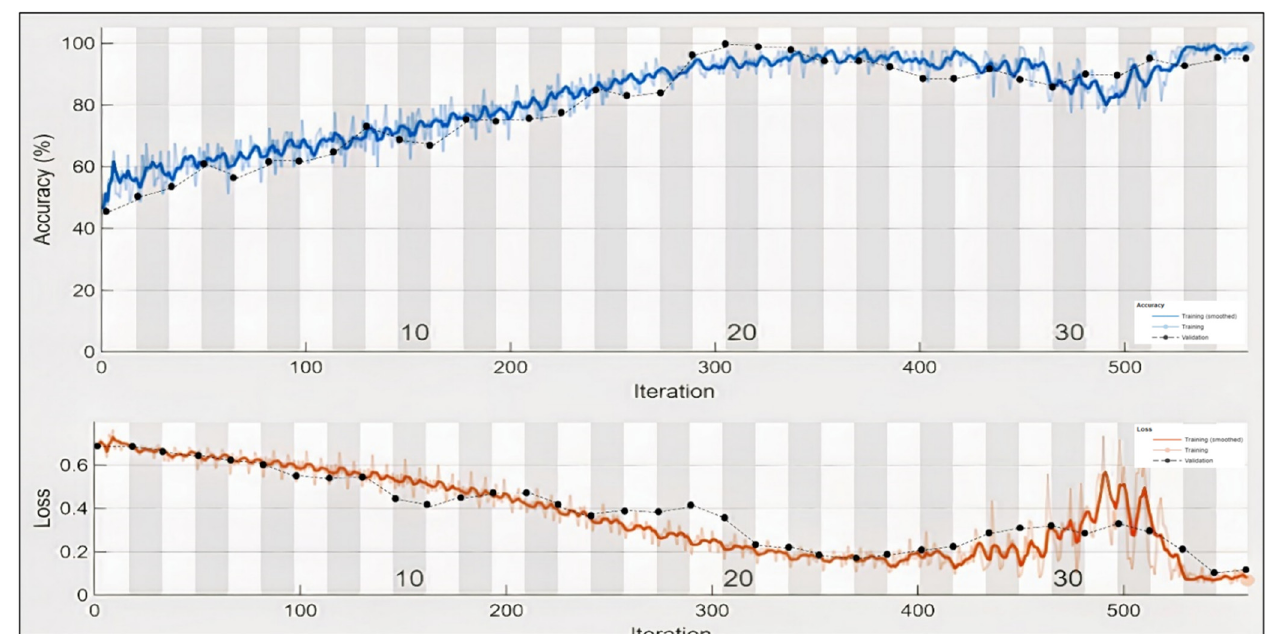
Figure 15. Training progress of Valence label. Table 4. Valence label results.